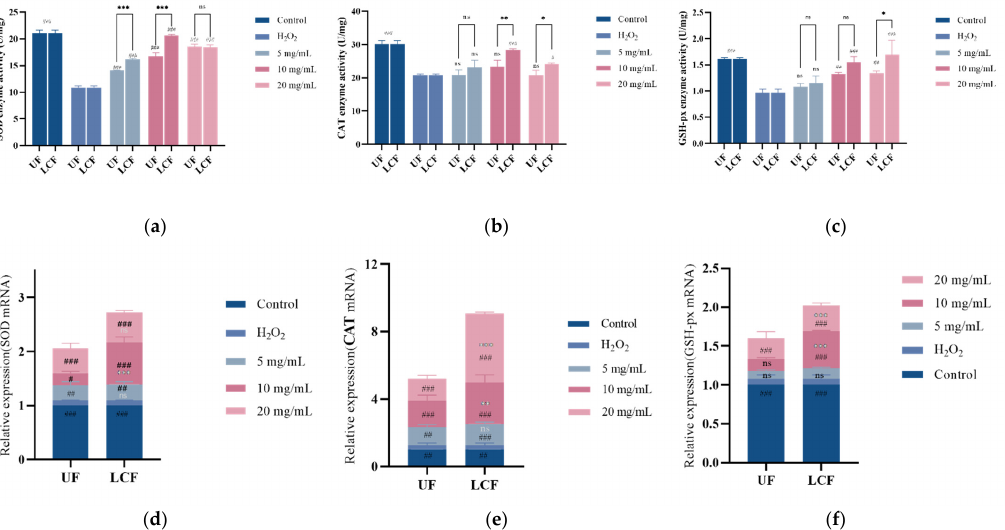
Antioxidants 2022 , 11 , x FOR PEER REVIEW 12 of 24